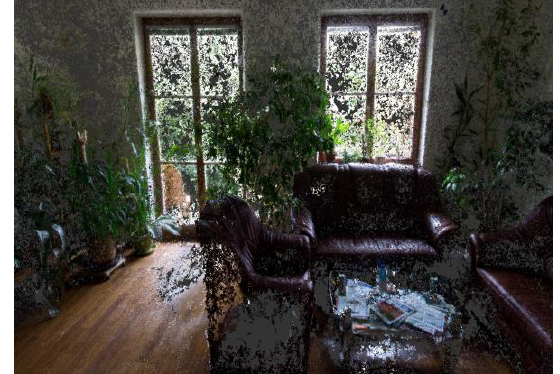
Figure 2. Point cloud created in Agisoft Photoscan from images captured with fisheye